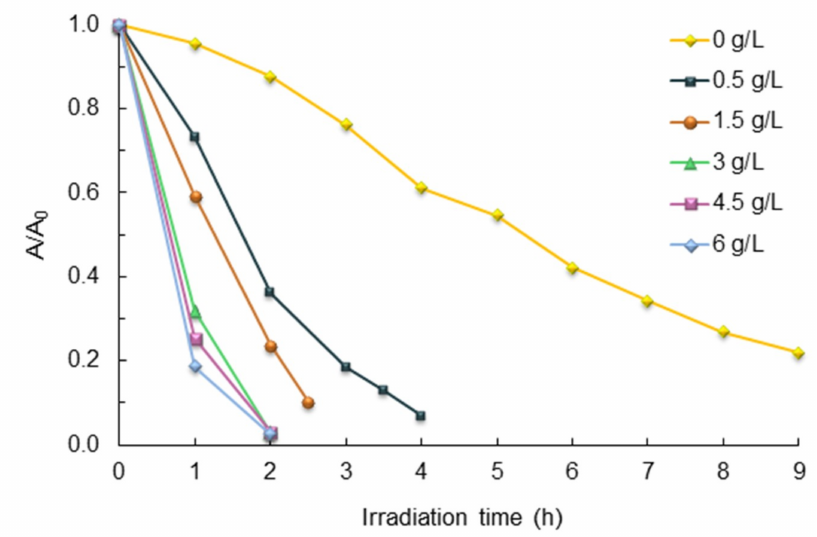
Figure 9. Photocatalytic degradation of Reactive Violet 5 (RV5) at di ff erent catalyst loads (c 0 RV5 = 30 ppm; pH = 10). A is the absorbance the dye solution at 560